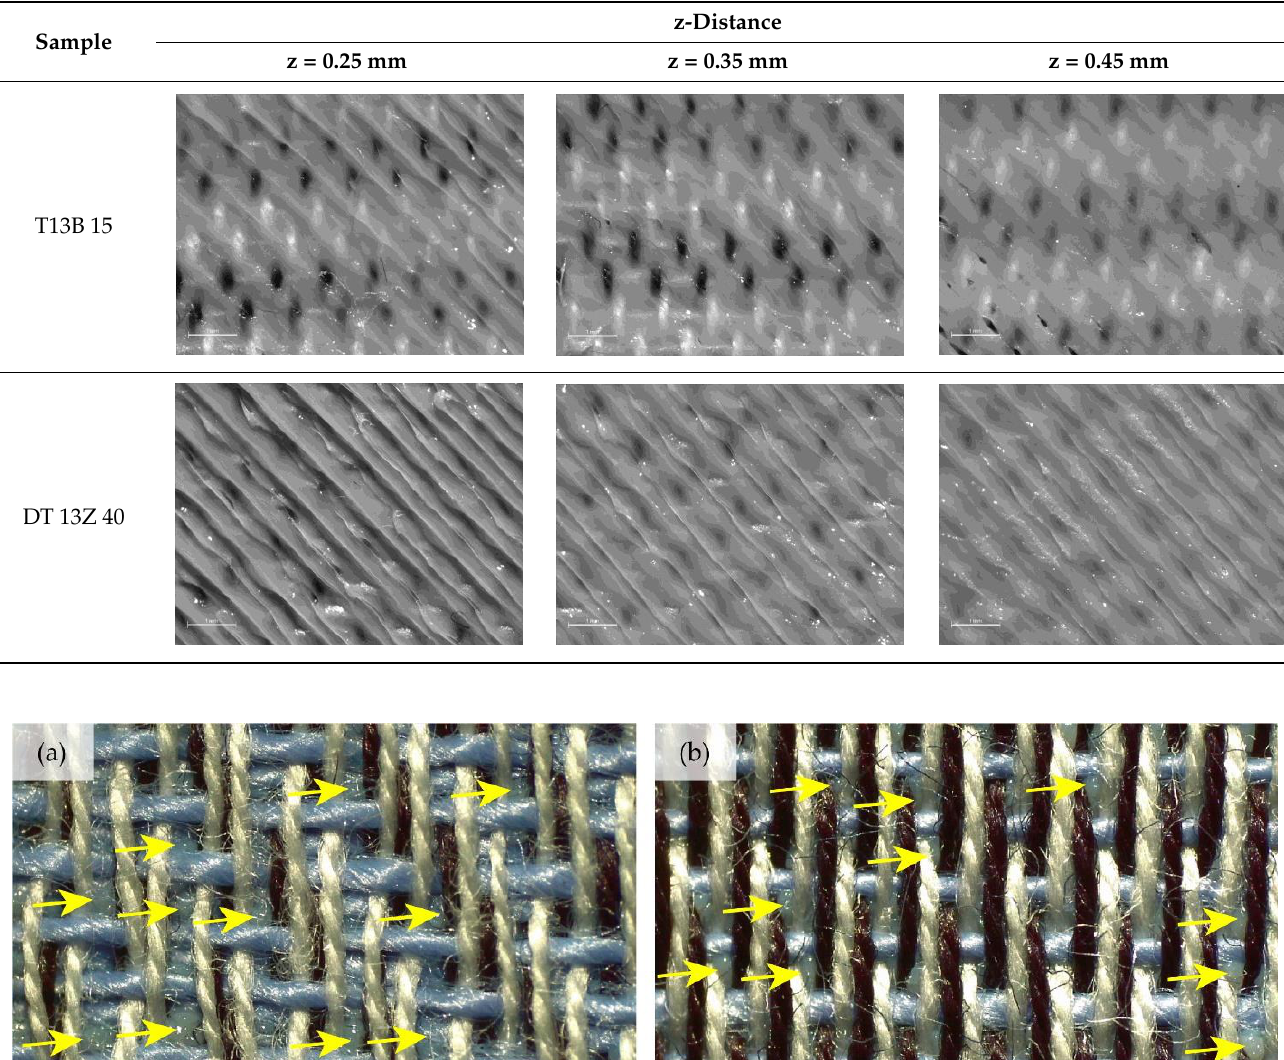
Table 10. Images of fabric samples (mag. 20×) printed at different z-distances (0.25 mm, 0.35 mm, and 0.45 mm).